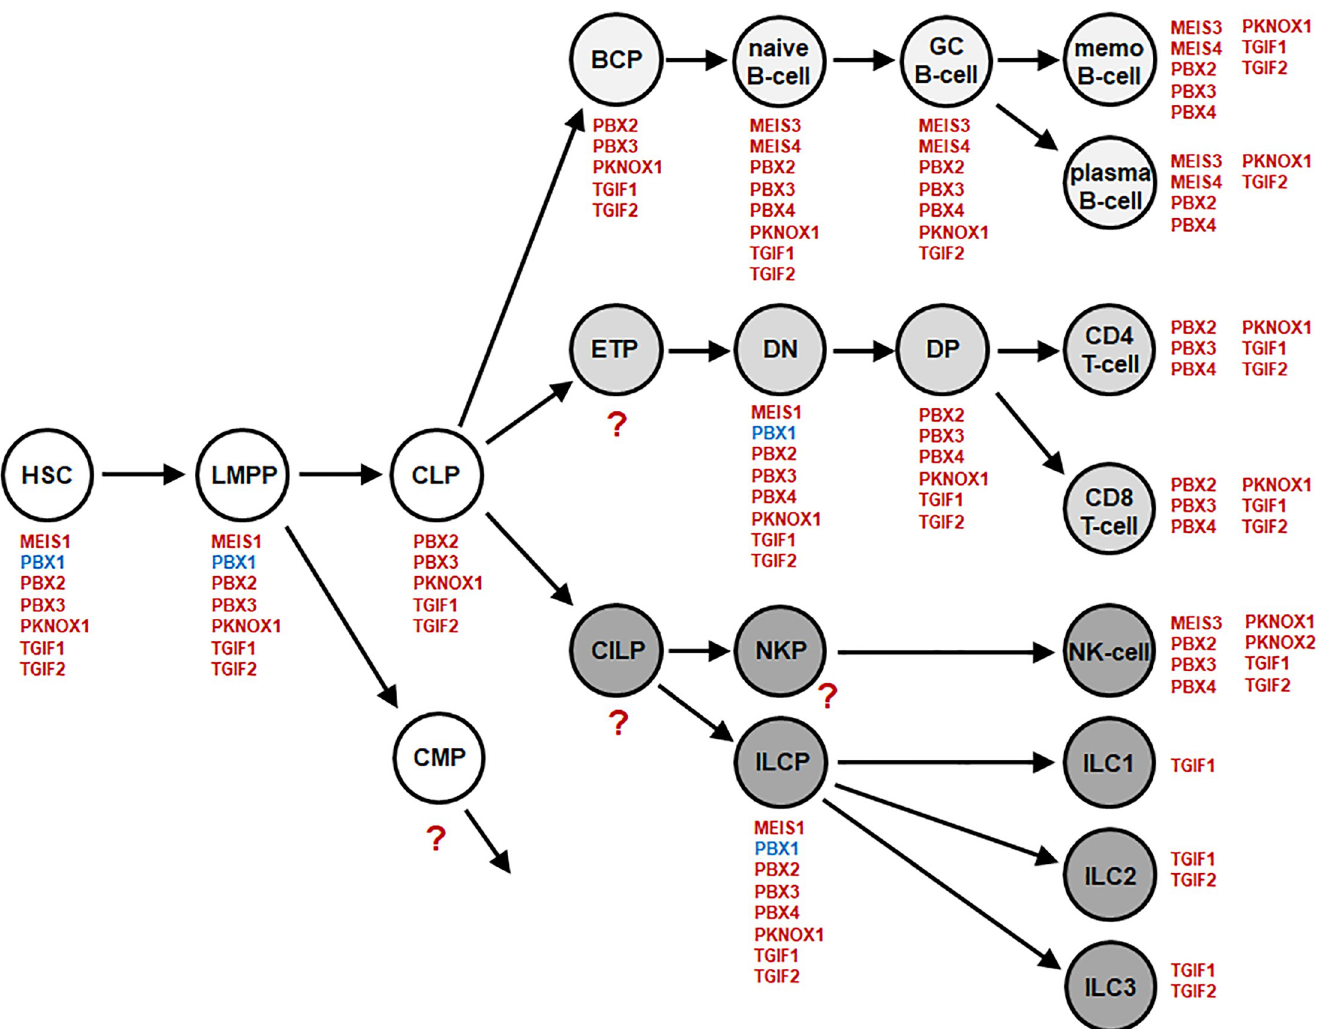
Fig 1. Lymphoid TALE-code. This diagram summarizes the screening results for expression of TALE homeobox genes (red) in early hematopoiesis and lymphopoiesis. We have termed this expression pattern TALE-code. Expression of PBX1 (blue) was detected in HSC, LMPP, DN T-cells and ILCP. BCP: B-cell progenitor, CILP: common innate lymphoid progenitor, CLP: common lymphoid progenitor, CMP: common myeloid progenitor, DN: double negative T-cell, DP: double positive T-cell, ETP: early T-cell progenitor, GC: germinal center, HSC: hematopoietic stem cell, ILC: innate lymphoid cell, ILCP: innate lymphoid cell progenitor, LMPP: lymphomyelo-primed progenitor, memo: memory, NKP: NK-cell progenitor. https://doi.org/10.1371/journal.pone.0246603.g001 five genes: IRX3, MEIS1, MEIS3, PBX1, and PBX4 (S3 Fig). Thus, these analyses indicated that